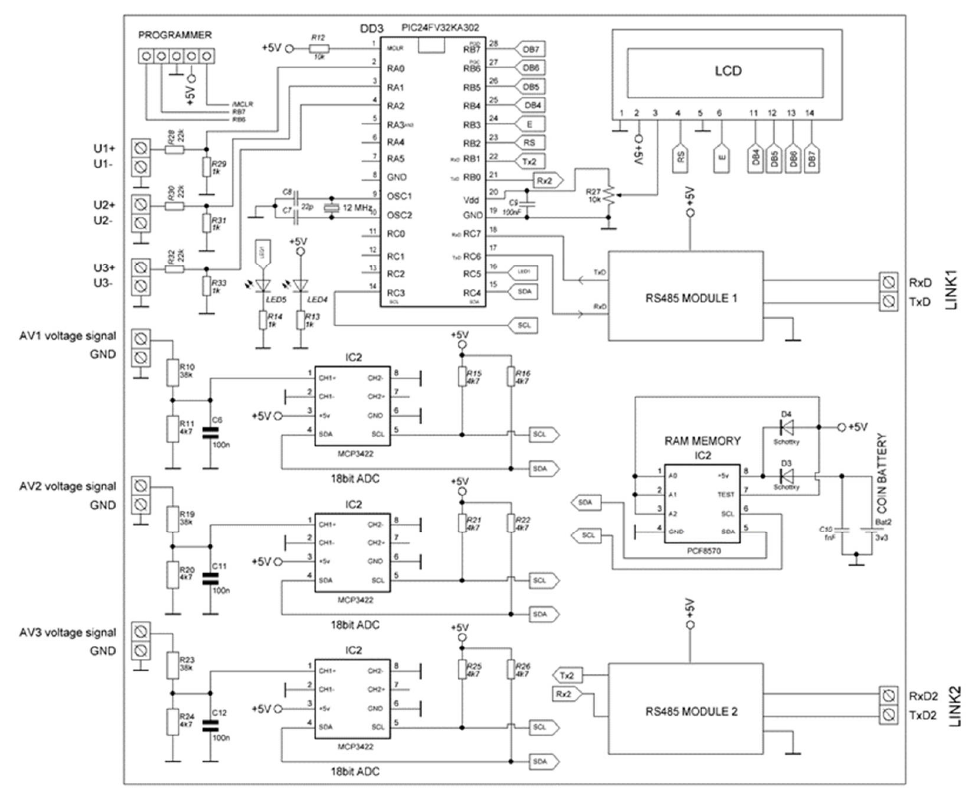
Figure 3. Scheme of solar power plant operating parameter data collection and processing system.